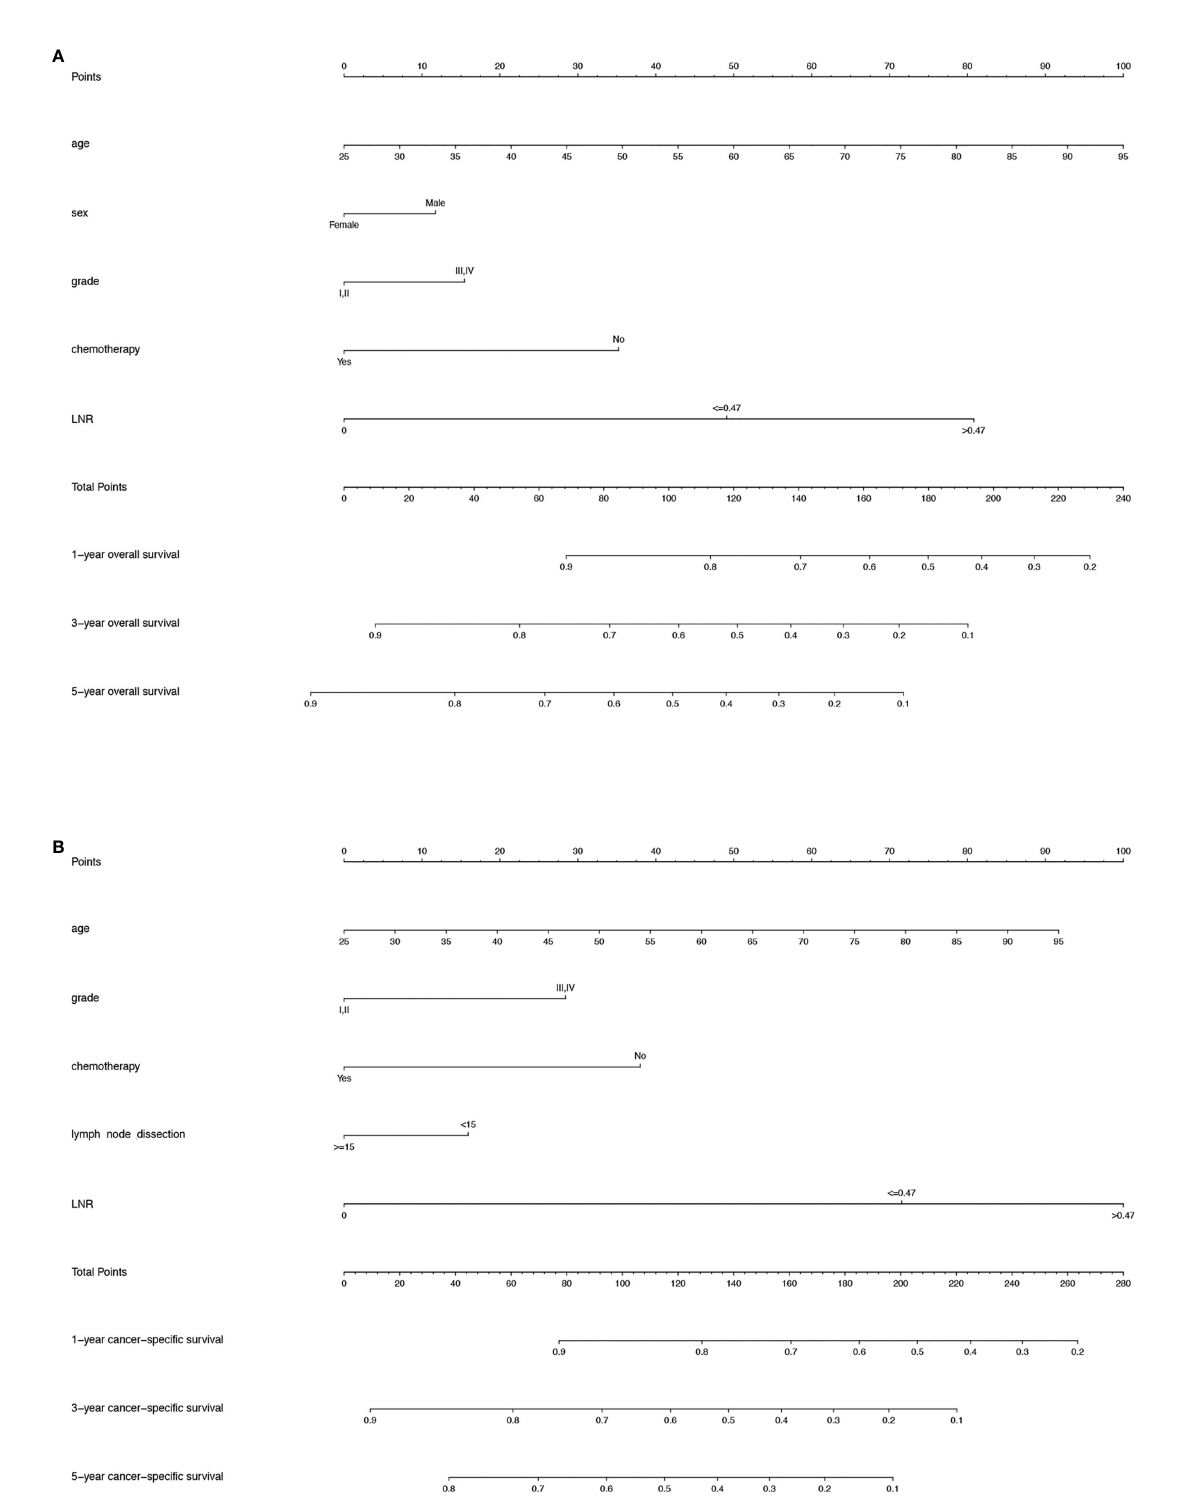
FIGURE 3 (A) Nomogram predicting the 1-, 3- and 5-year OS rates for PDA patients after surgery. (B) Nomogram predicting the 1-, 3- and 5-year CSS rates for PDA patients after surgery. OS, overall survival; PDA, primary duodenal adenocarcinoma; CSS, cancer-speci fi c